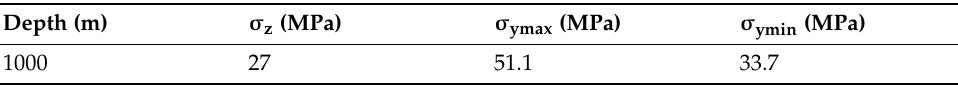
Table 3. Initial in situ stress at the depth of the Jiaojia Gold Mine.